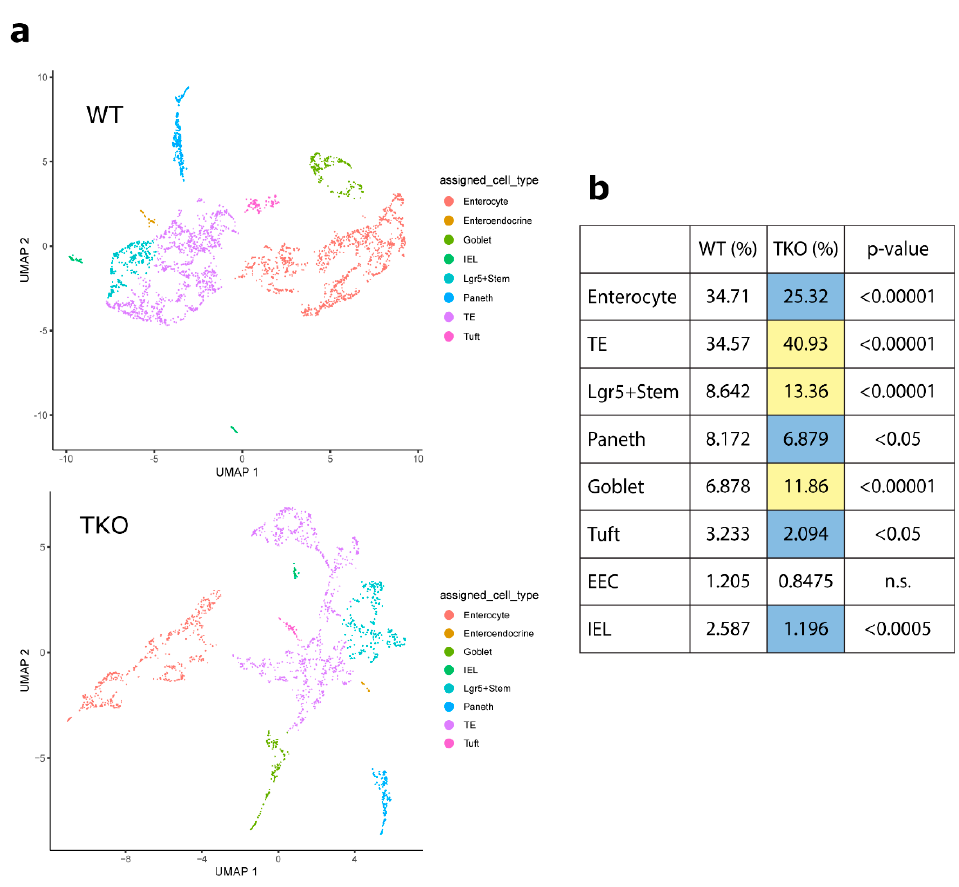
Figure 1. TKO ( Tipe0 − / − ) intestine is shifted towards an undifferentiated state. ( a ) Uniform Manifold Approximation and Projection (UMAP) plots colored by cell type, n = 3 mice/genotype, wild-type (WT): 3402 cells, TKO: 2006 cells; ( b ) Tabulated percentages of cell types, colored by difference between TKO and WT (purple (negative), yellow (positive)). Significance determined by z -test for independent proportions. n.s. = not